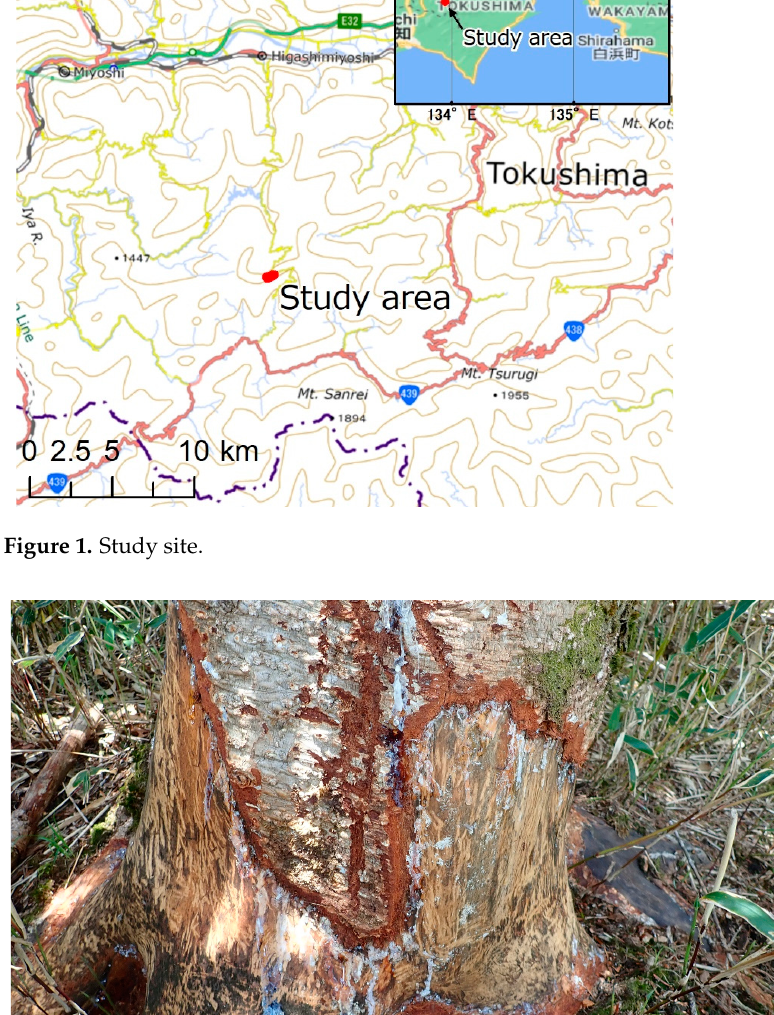
Figure 1. Study site.